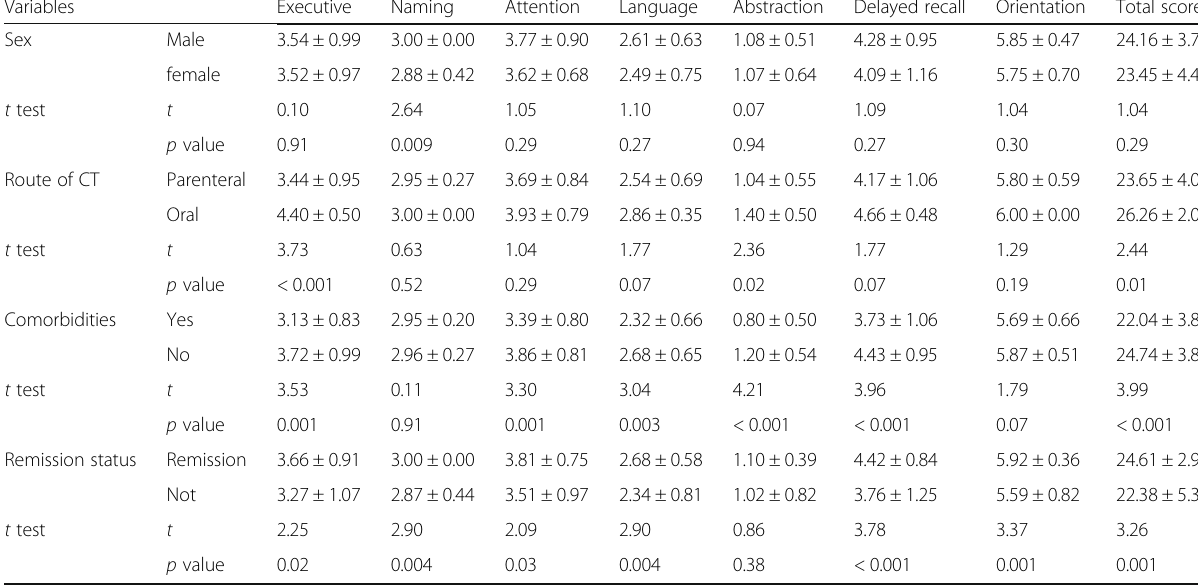
Table 4 Impact of patient sex, route of chemotherapy, associated comorbidities, and remission status on the score of each component of cognitive functions Variables Executive